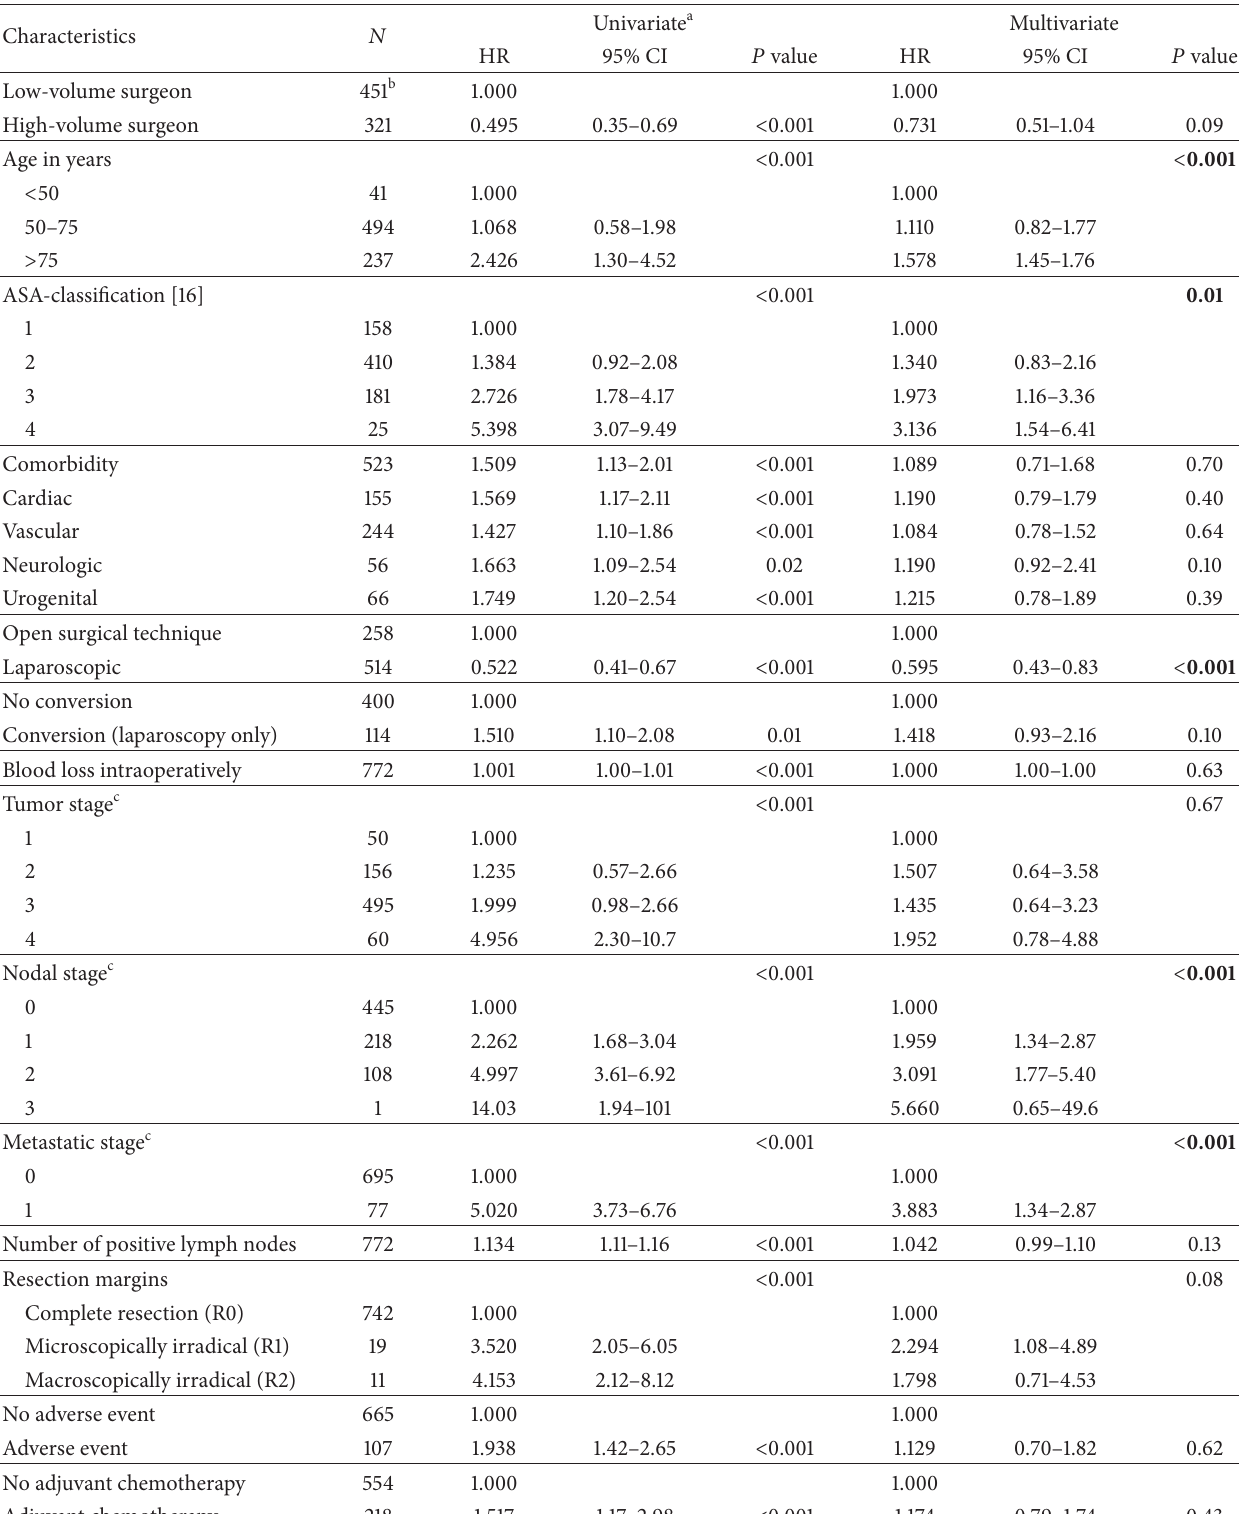
Table 5: Univariate and multivariate analysis of overall